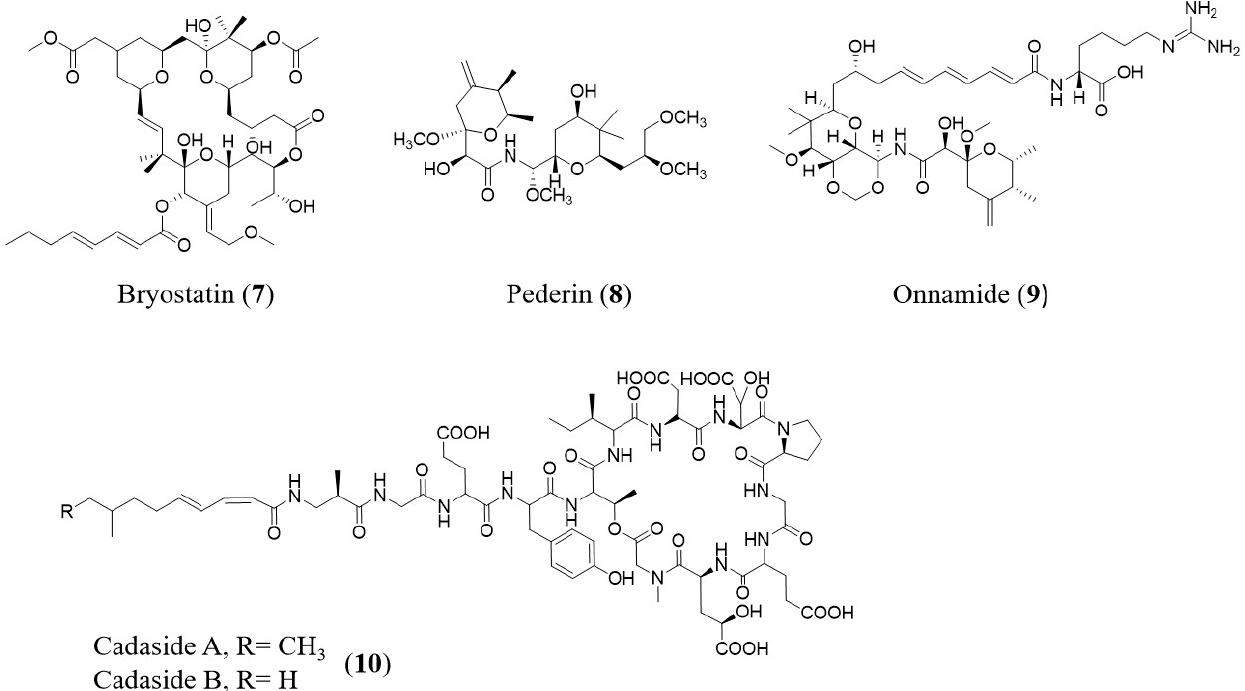
Figure 3. Natural products identified/studied by sequencing ‐ based approaches.